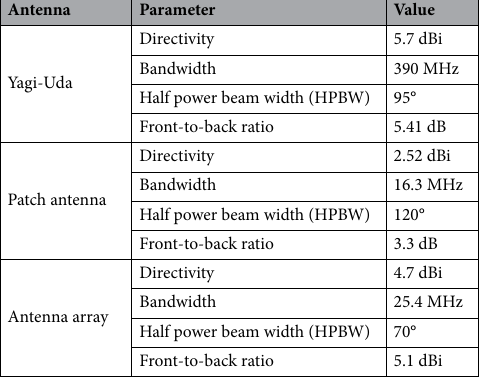
Table 1. Parameters of the antennas analyzed for their resonance frequency.